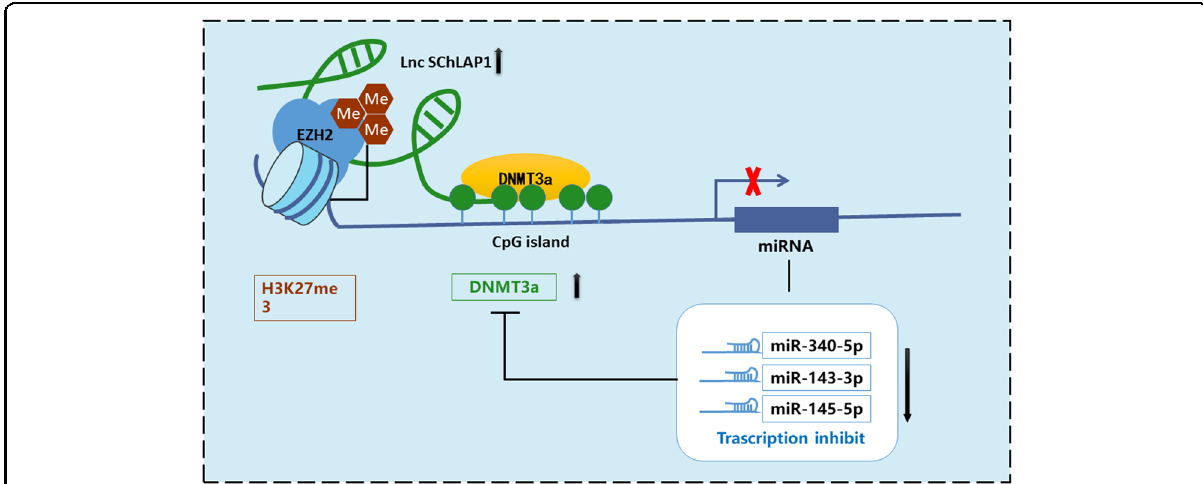
Fig. 8 Schematic of the proposed mechanism of lncRNA SChLAP1 in prostate cancer. lncRNA SChLAP1 recruit EZH2 and DNMT3a to enhance H3K27me3 and DNA methylation, which will suppress the expression of miR-340-5p/miR-143-3p/miR-145-5p. DNMT3a is a common target gene of miR-340-5p/miR-143-3p/miR-145-5p. miR-340-5p/miR-143-3p/miR-145-5p was decreased while DNMT3a was increased in prostate cancer. There is a feedback loop between miR-340-5p/miR-143-3p/miR-145-5p and DNMT3a expression mediated the oncogenic roles of SChLAP1 in prostate cancer